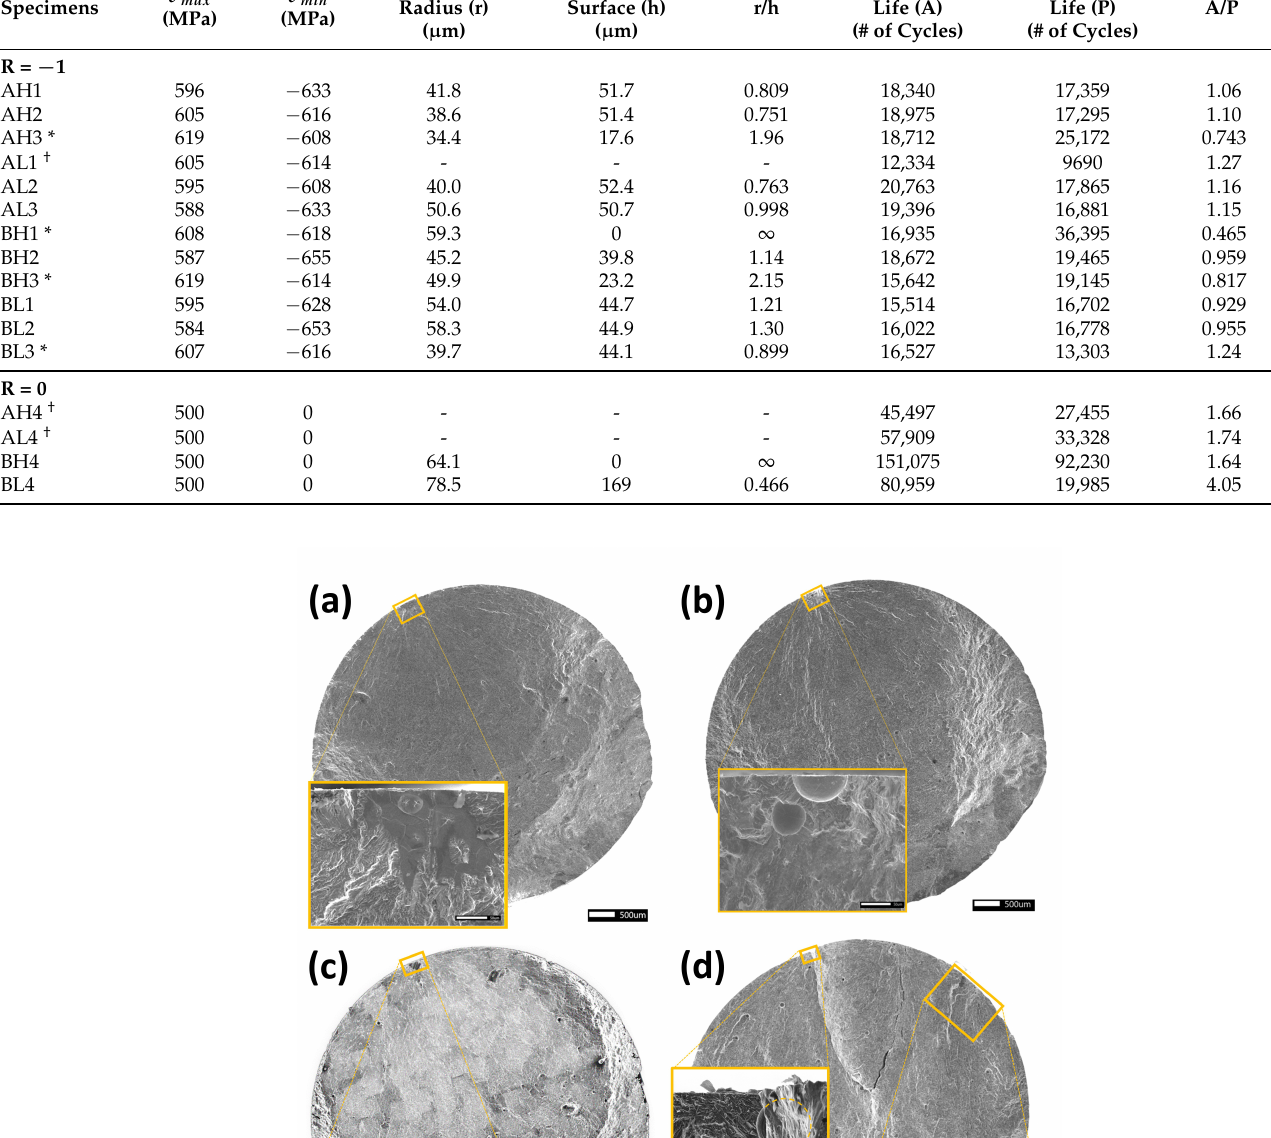
Table 3. Results from the fatigue testing and prediction based on fractography measurements. If multiple crack initiation sites were found, only the largest initiator is listed. r and h are parameters in the Murakamis criterion (1). h = 0 indicates that the center of the equivalent spherical initiator is outside the specimen surface. Stress values are midlife stresses. ∗ More than one initiation site contributed to failure. † Crack initiation at a lack of fusion (LOF) defect. A, Build A; B, Build B; H, higher; L, lower. Specimens